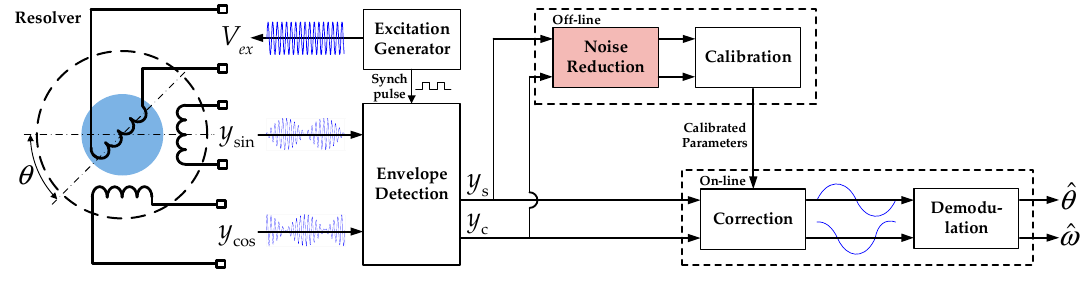
Figure 1. Schematic block diagrams of a resolver and RDC.